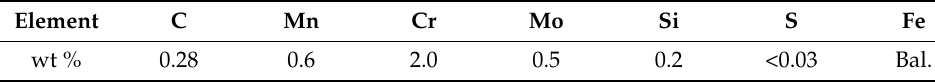
Table 1. Chemical composition of AISI P20 plastic mold steel.